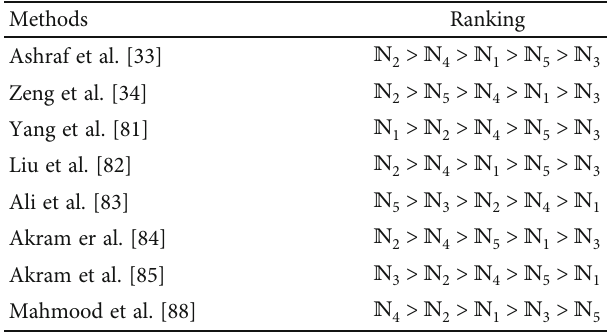
Test criteria 2: an e ffi cient MAGDM approach should obey transitive properties.